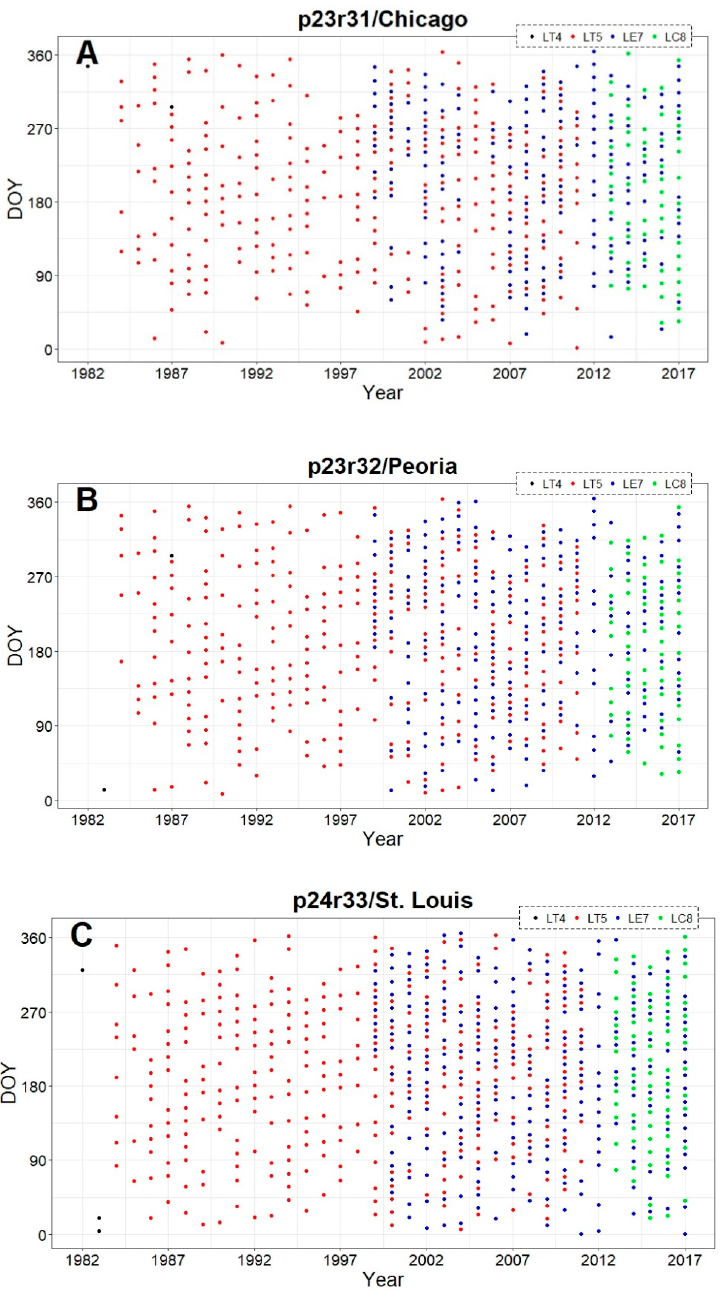
Figure 2. Distribution of Landsat data utilized for LULC change by footprint, sensor type, year and Julian date of the year (DOY) for ( A ) Chicago (p23r31), ( B ) Peoria (p23r32), and ( C ) St. Louis (p24r33).